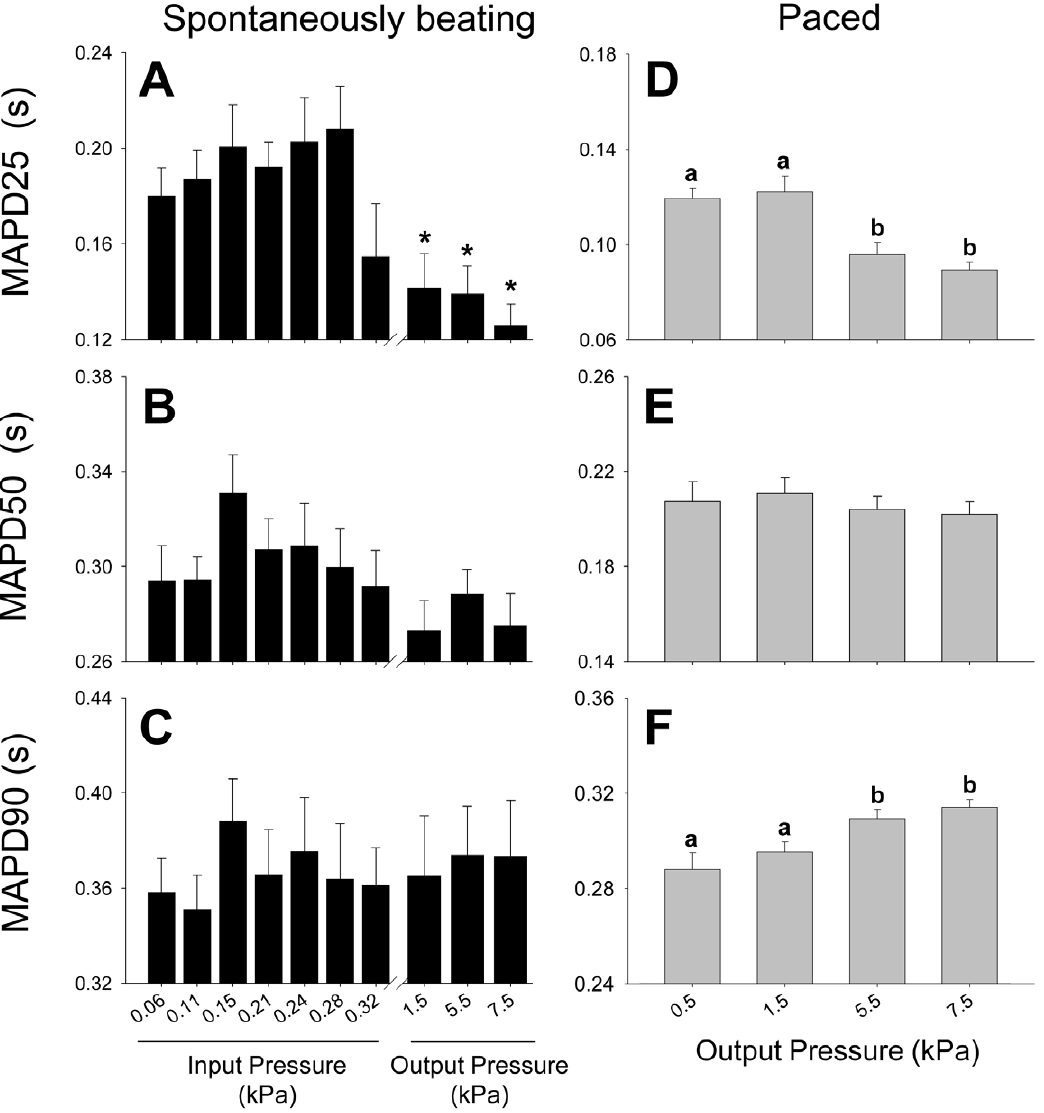
Figure 5. The effect of stretch on the MAP of the fish heart. Spontaneously beating hearts (n=8) are represented by black bars. These hearts initially had their P i increased to 0.322 6 0.011 kPa before P o was increased to 7.5 kPa. The grey bars represent hearts extrinsically paced at 0.8 Hz (n=8). P i for the extrinsically paced hearts was held at 0.322 6 0.011 kPa and P o was increased. MAPD is shown at MAPD25 (A,D), MAPD50 (B,E) and MAPD90 (C,F) (mean 6 S.E.M, p , 0.05). The only significant effect of stretch upon the MAPD of spontaneously beating hearts is to shorten MAPD25 (* indicate significant differences, p , 0.05, One-Way ANOVA, Student-Newman-Keuls post hoc ). Hearts extrinsically paced at 0.8 Hz show a significant decrease in MAPD25 and a significant increase in MAPD90, representing a classical stretch-induced cross over ( p , 0.05, One-Way ANOVA, Student- Newman-Keuls post hoc , significant differences between columns marked a and b).